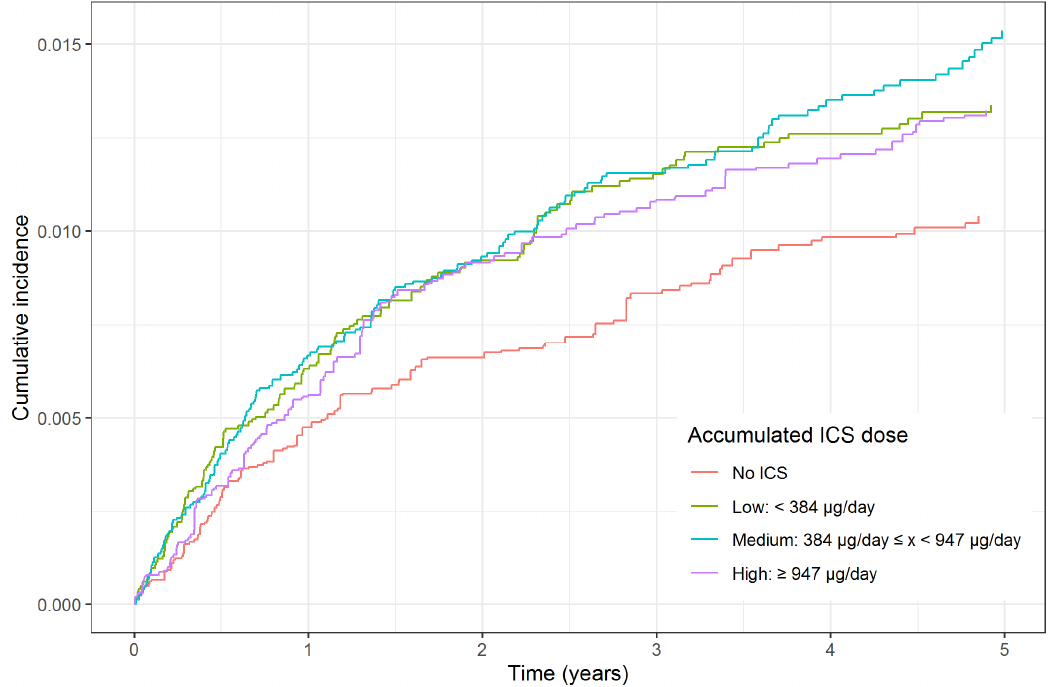
Figure 3. Cumulative incidence function for hospital admission with either depression, anxiety or inverse probability of treatment weighing. Abbreviations: ICS: Inhaled bipolar disorder using inverse probability of treatment weighing. Abbreviations: ICS: Inhaled cor- ticosteroid.